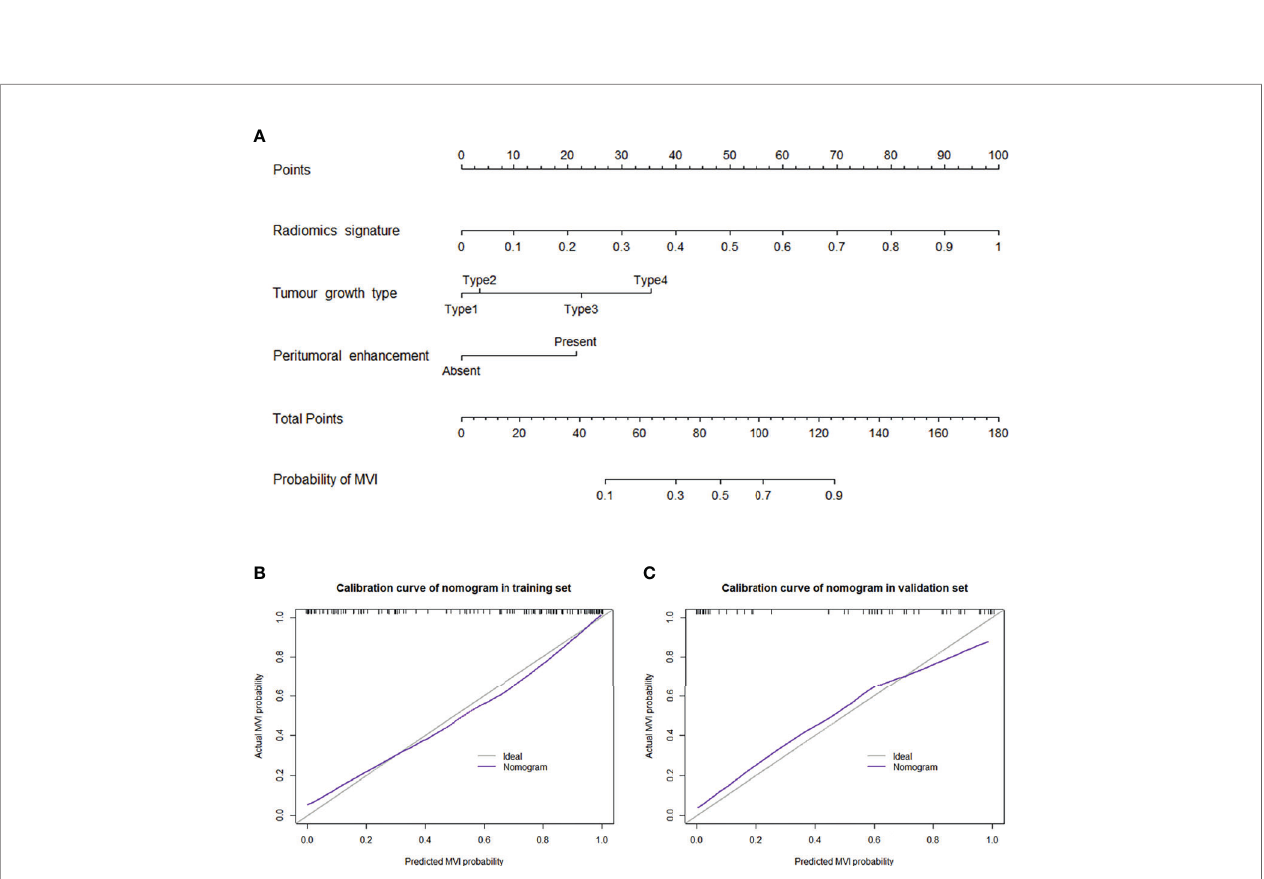
FIGURE 3 | (A) Nomogram for the prediction of MVI presence in patients with solitary HCC. The nomogram was established based on the MR radiomics signature and 2 independent clinicopathological risk factors: peritumoral enhancement and tumour growth type (type 1: smooth regular nodule growth; type 2: focal extranodular growth; type 3: multinodular con fl uent growth; and type 4: in fi ltrative growth). Plots (B, C) present the calibration curve of the nomogram in the training and validation sets, respectively. The 45° gray line represents the ideal prediction, and the purple line represents the predictive performance of the nomogram. The purple line has a closer fi t to the gray line, which indicates that the predicted MVI probability has good agreement with the actual presence of